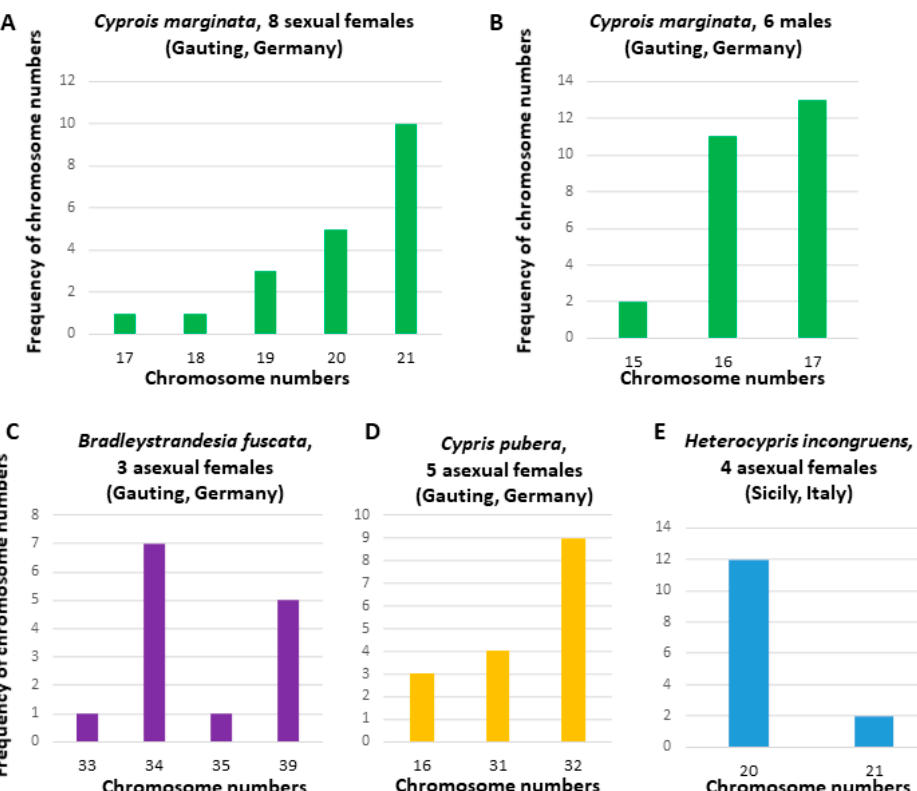
Figure 2. Chromosome numbers in ostracod species of the family Notodromadidae, representing sexually reproducing ostracods, and of the family Cyprinidae, representing asexual and geographically parthenogenetic ostracods. ( A , B ) a fully sexual species Cyprois marginata , ( A ) females, n = 8 and ( B ) males, n = 6; ( C – E )/asexual species: ( C ) Bradleystrandesia fuscata , asexual females (males are unknown in Europe), n = 3; ( D ) Cypris pubera , asexual females (geographical parthenogenesis with males confined to Turkey), n = 5; ( E ) Heterocypris incongruens , asexual females (geographical parthenogenesis with males confined to the east of Europe), n = 4.